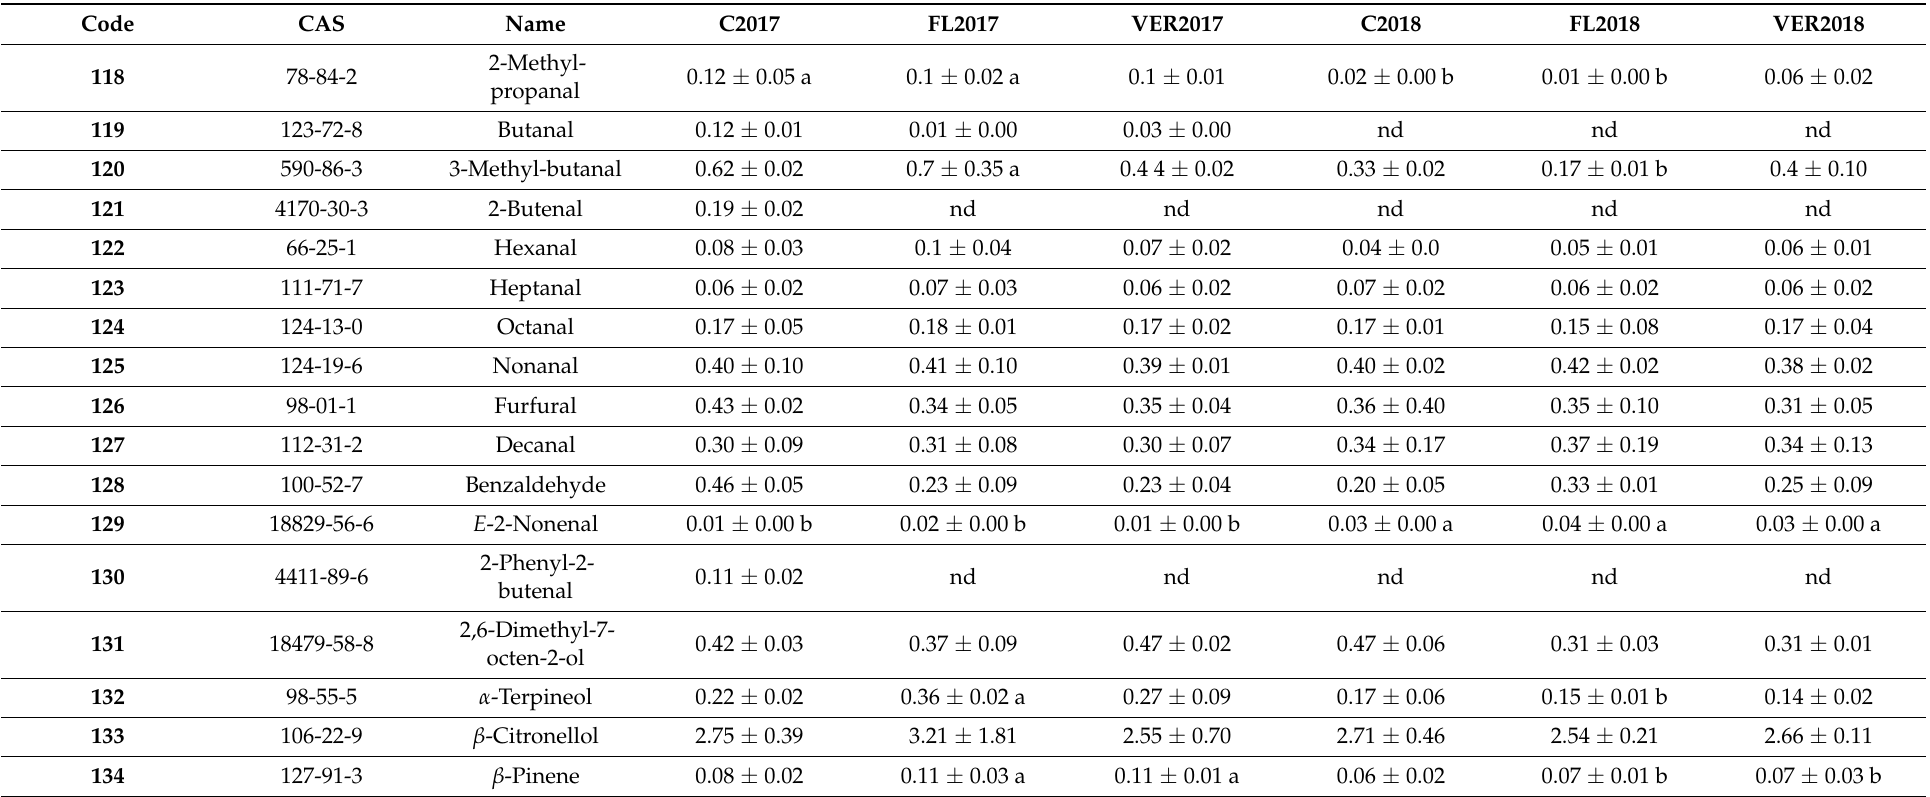
Table 7. Effects of defoliation treatments and vintage on concentrations of the aldehydes, monoterpenoles, and monoterpenes ( µ g/L). (The quantification was conducted in the same manner as Table 6). C = control; FL = removal of six leaves before flowering; VER = removal of six leaves at the end of